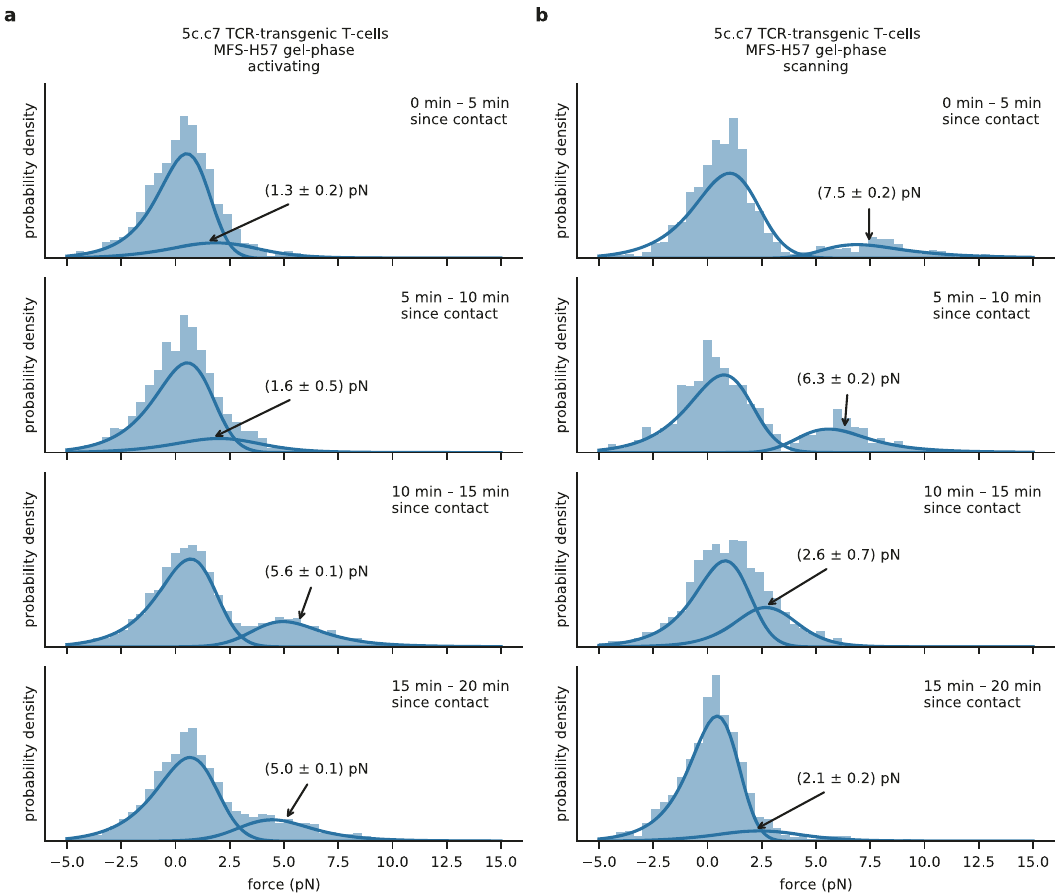
Fig. 3 Single-molecule force pro fi les in the course of synapse formation. We used MFS-H57 data recorded on 5c.c7 T-cells contacting activating ( a ) or non-activating ( b ) gel-phase SLBs. Data were grouped with respect to the time elapsed since the corresponding T-cell fi rst contacted the SLB. Fit results for the average pulling forces are indicated in the fi gure. The following number of data points were used. Activating conditions: 0 – 5 min, n = 1579 (38 movies); 5 – 10 min, n = 2701 (60 movies); 10 – 15 min, n = 3403 (69 movies); 15 – 20 min, n = 4047 (75 movies). Scanning conditions: 0 – 5 min, n = 1140 (29 movies); 5 – 10 min, n = 927 (21 movies); 10 – 15 min, n = 1105 (32 movies); 15 – 20 min, n = 1410 (32